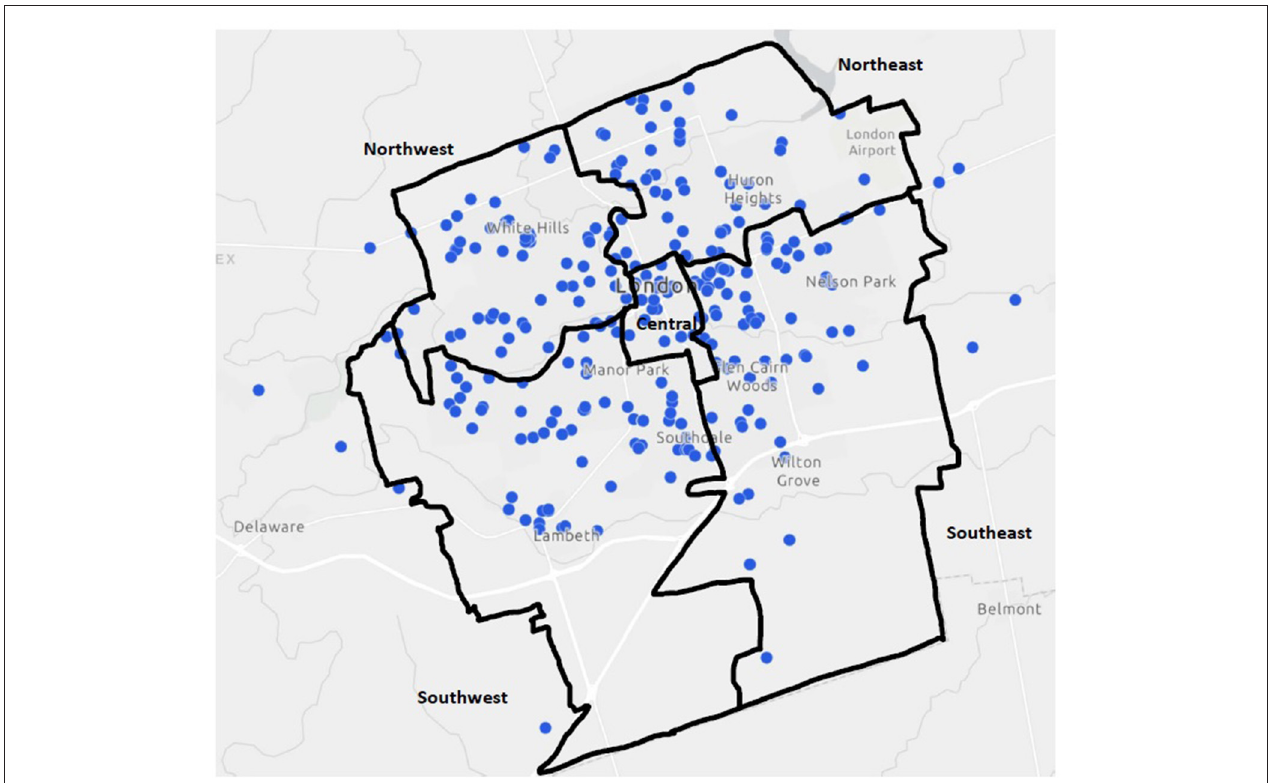
FIGURE 1 | All sport delivery points in the five City of London planning districts.